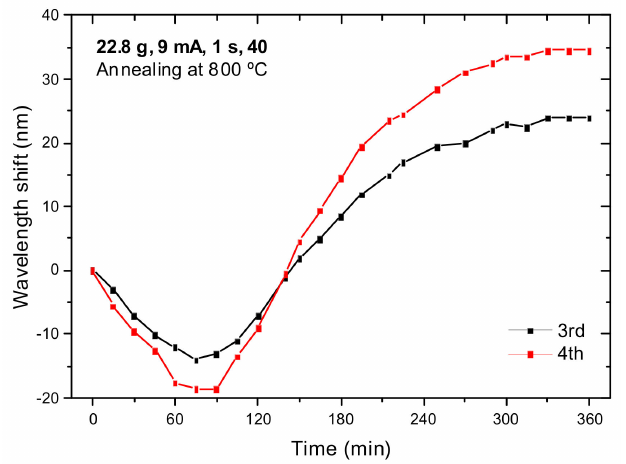
Figure 6. Time dependence of two resonances during annealing at 800 ◦ C for 6 h. Reprinted from [86].